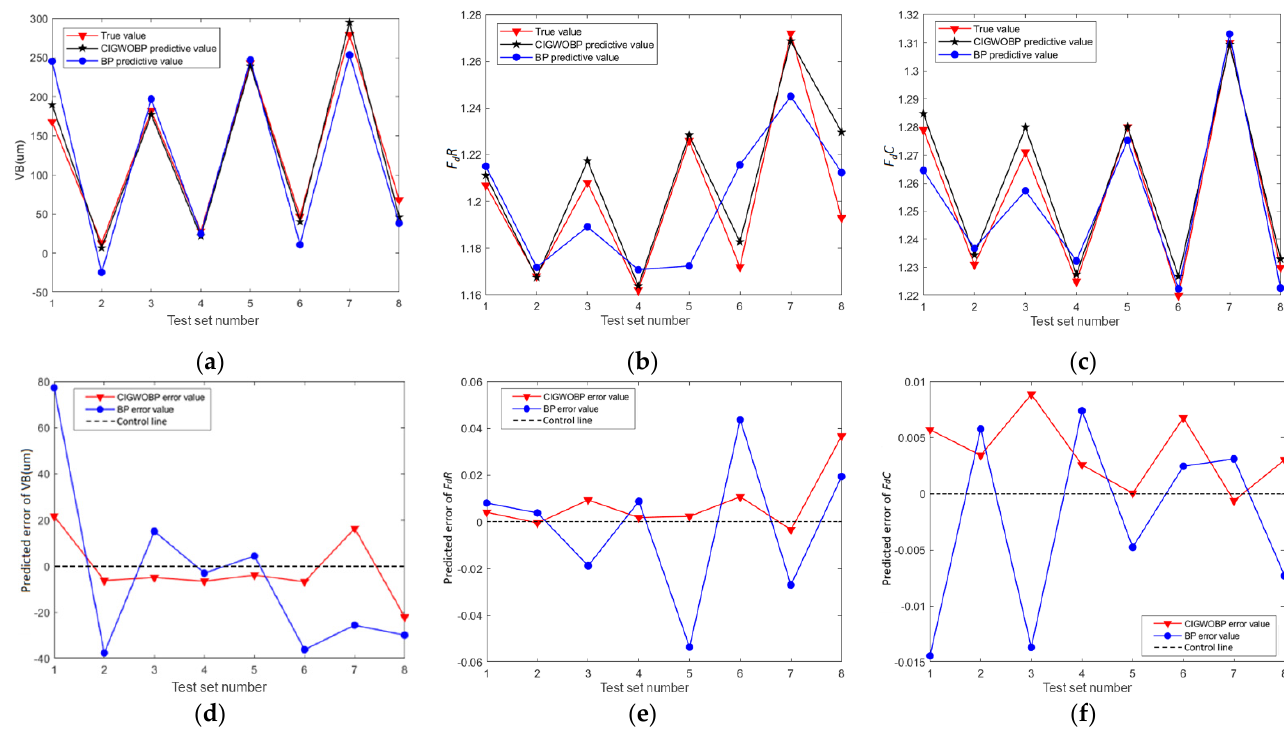
Figure 16. Prediction results: ( a )VB; ( b ) F d R ; ( c ) F d C ; ( d ) error of VB; ( e ) error of F d R ; ( f ) error of F d C .